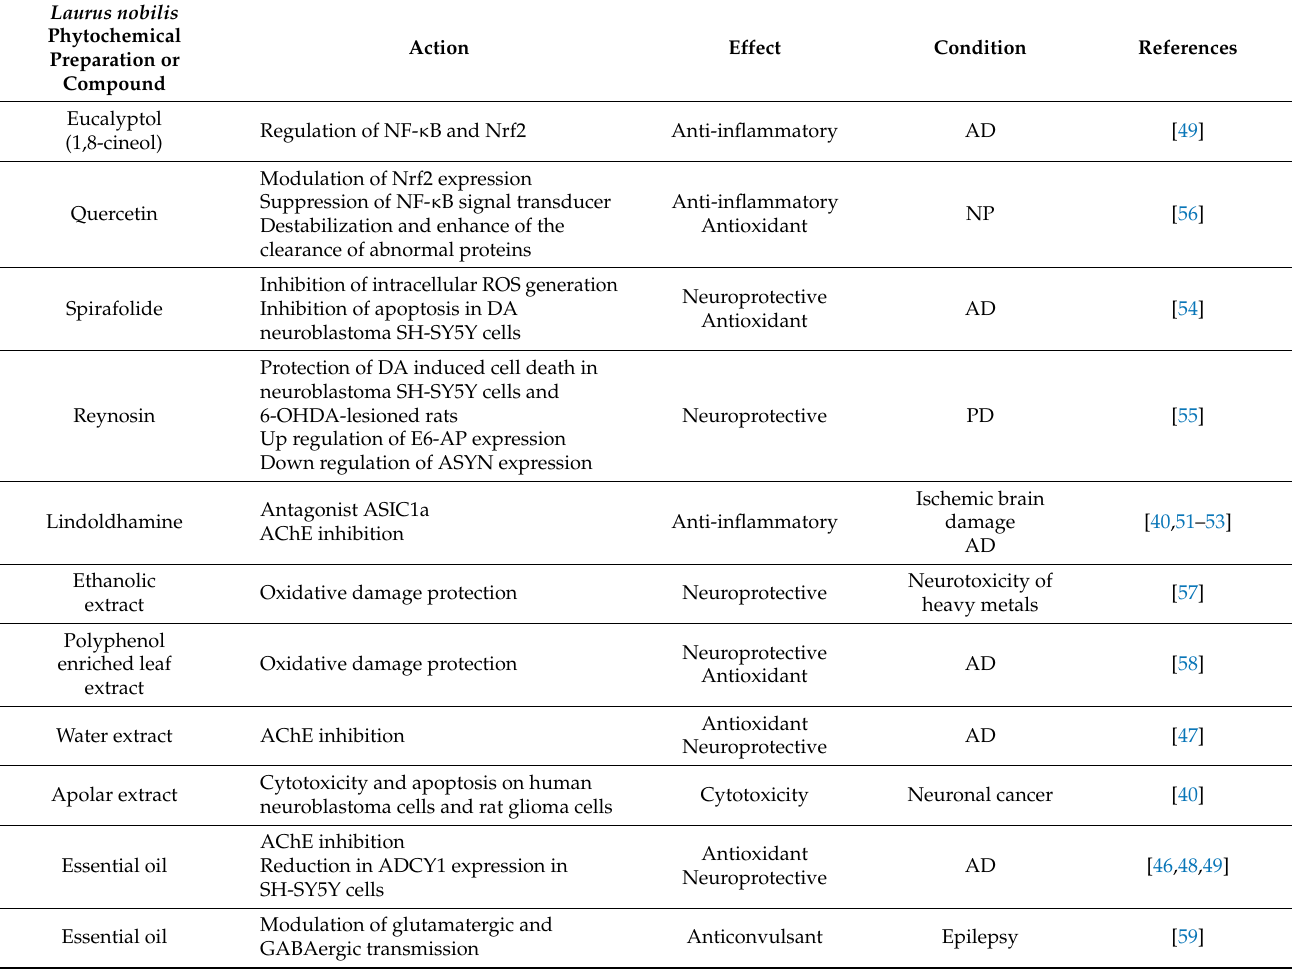
Table 1. Laurus nobilis bioactive components with neuroprotective